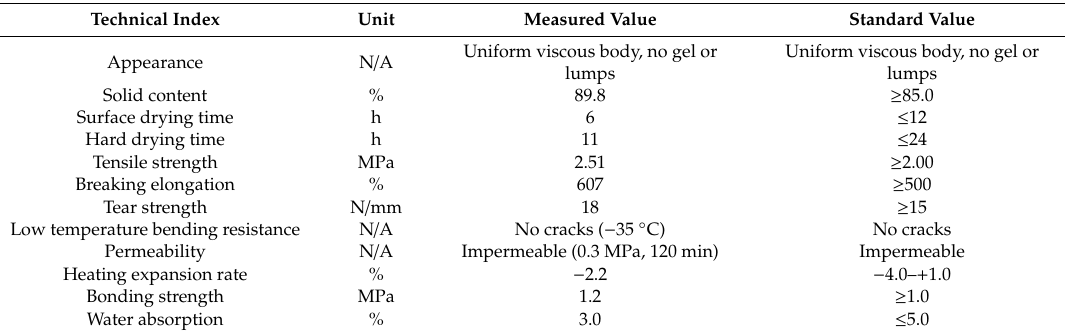
Table A8. Technical parameters of